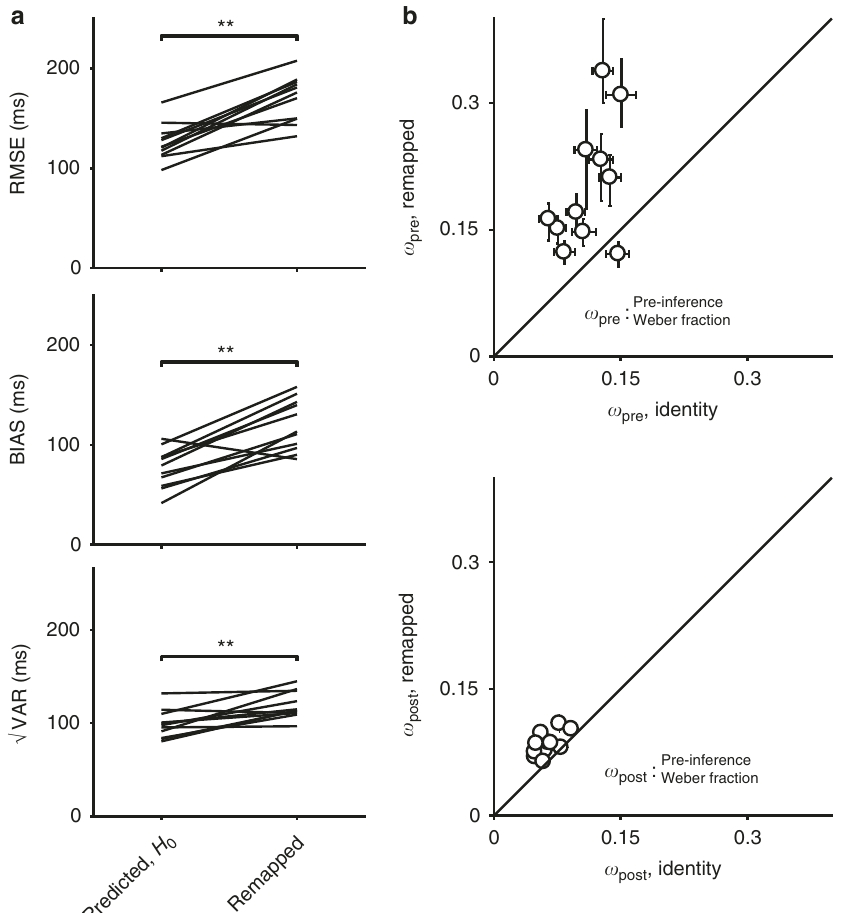
Fig. 3 Summary of subjects ’ behavior in the time measurement and production task, gain = 1.5. a Comparison of RMSE (top), BIAS (middle), and √ VAR (bottom) for all subjects. The lines connect values predicted in the remapped context assuming no additional MTN (predicted, H 0 ; left) based on the identity context (i.e., multiplied by the gain of 1.5) to actual values observed from behavior (gain = 1.5; right). Almost every subject had higher RMSE and BIAS than was predicted assuming no additional MTN. There was also a smaller increase in √ VAR compared to predictions (**: p < 0.01, Wilcoxon two- sided signed-rank test). b Fitted model parameters. We fi t an observer-actor model (see Methods) to each subject ’ s data independently for the two contexts. This model did not explicitly parameterize MTN, and so any differences in MTN across contexts were re fl ected in the Weber parameters w pre , capturing noise prior to inference and w post , capturing noise following inference. Most subjects were fi t with much higher values of w pre (top) in the remapped context, re fl ecting additional reliance on prior information consistent with a late inference strategy. There was also a more modest increase in w fi dence intervals estimated using a bootstrap procedure ( n = 1000). In the bottom post for the remapped context (bottom). Error bars represent 95% con panel, error bars are small and not visible (i.e., behind the open